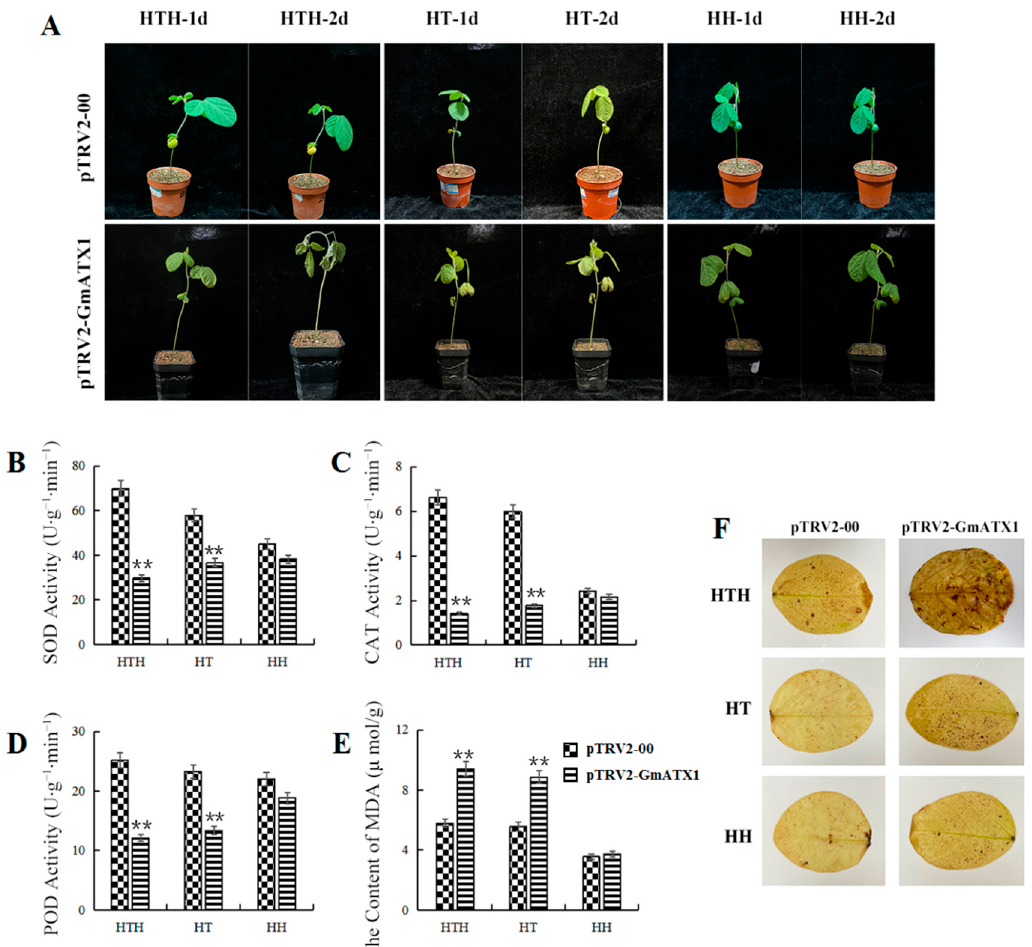
Figure 3. Effects of HT, HH, and HTH stresses on the GmATX1 -silent soybean line. ( A ) Illustration of the 5-week-old seedlings of the GmATX1 -silent soybean line (pTRV2- GmATX1 ) and control (pTRV2-00) treated under HT (40/30 °C, 10 h/14 h (light/dark) and 70% relative humidity (RH)), HH (30/20 °C, 10 h/14 h (light/dark) and 100% RH), and HTH (40/30 °C, 10 h/14 h (light/dark) and 100% RH) condition, respectively, for 2 d. ( B – E ) Activities of SOD, CAT, and POD and the content of MDA in the leaves of 5-week-old seedlings of the gene-silenced soybean line (pTRV2- GmATX1 ) and control (pTRV2-00) treated under HT, HH, and HTH conditions, respectively, for 2 d. ( F ) Staining of H 2 O 2 in the leaves of 5-week-old seedlings of the gene-silenced soybean line (pTRV2- GmATX1 ) and the control (pTRV2-00) treated under the HT, HH, and HTH conditions, respectively, for 2 d. The values shown are mean ± SD from three biological replicates. ** Indicates significant differences between the GmATX1 -silent soybean line (pTRV2- GmATX1 ) and the control (pTRV2-00) at p < 0.01. To further clarify the physiological and biochemical basis of GmATX1 function in pro- moting stress tolerance, 5-week-old seedlings of the GmATX1 -silent soybean line (pTRV2- GmATX1 ), treated under HTH, HT, and HH conditions, respectively, were used. The results indicated that compared to those of the control, the activities of catalase (CAT), superoxide dismutase (SOD), and peroxidase (POD) in the seedling leaves of the gene-silenced soybean line were significantly ( p < 0.01) reduced (Figure 3B–D), whereas the malondialdehyde (MDA) contents were significantly ( p < 0.01) elevated under the HT and HTH treatments (Figure 3E). Furthermore, higher levels of hydrogen peroxide (H 2 O 2 ) were also found in the leaves of the gene-silenced soybean line (Figure 3F). However, the antioxidase activities in the seedling leaves of the GmATX1 -silent soybean line were decreased, but not to a significant level under the HH condition, and the MDA content and H 2 O 2 levels